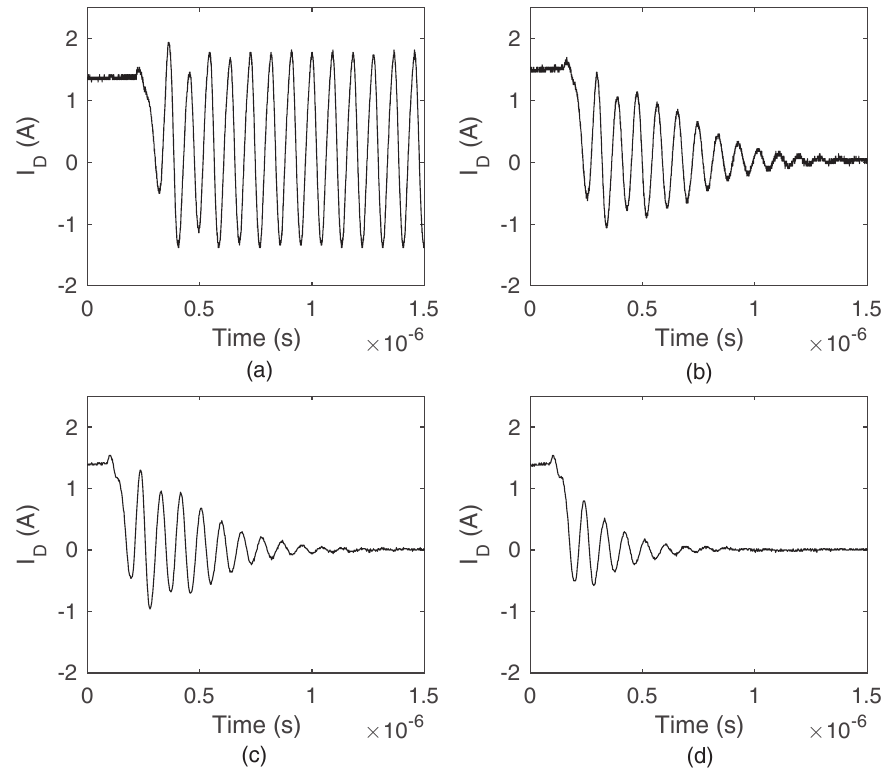
Figure 17. The experimental type I oscillation waveforms of the drain current I D with various R G with L S = 67 nH and L C = 410 nH. ( a ) R G = 2 Ω . ( b ) R G = 3 Ω . ( c ) R G = 3.6 Ω . ( d ) R G = 5 Ω